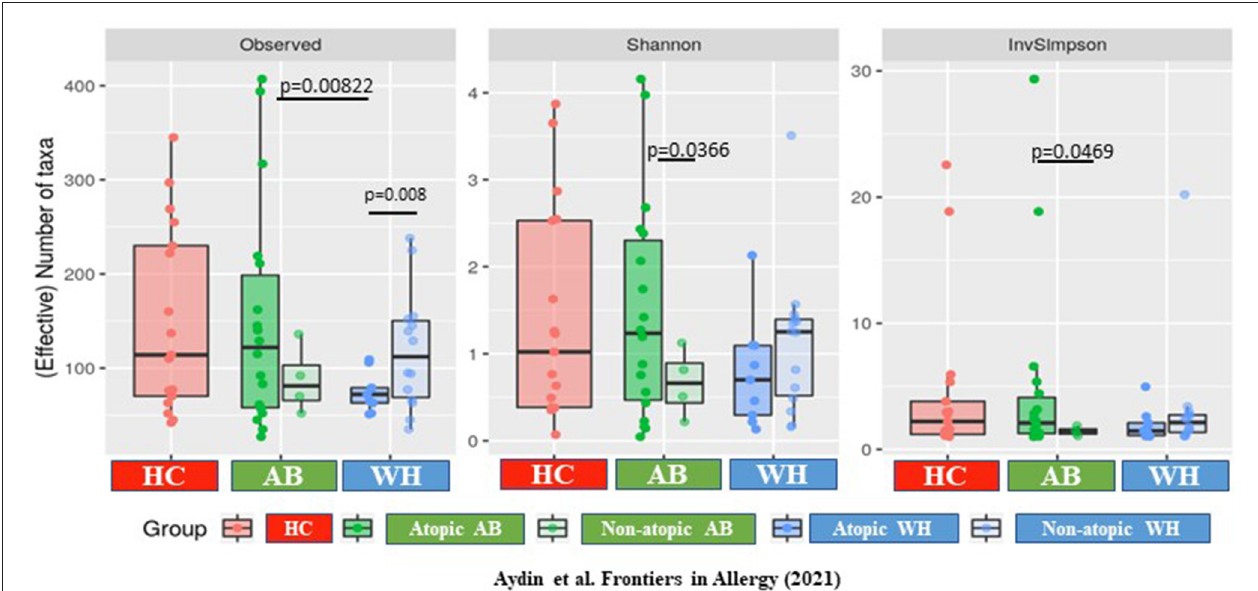
FIGURE 2 | The α -diversity differs between atopic and non-atopic diseased subjects. The α -diversity is increased in atopic AB but is decreased in WH (Observed p = 0.008, Shannon p = 0.066, InvSimpson p = 0.081) (AB, Asthmatics; WH, Wheezers; HC, Healthy controls).